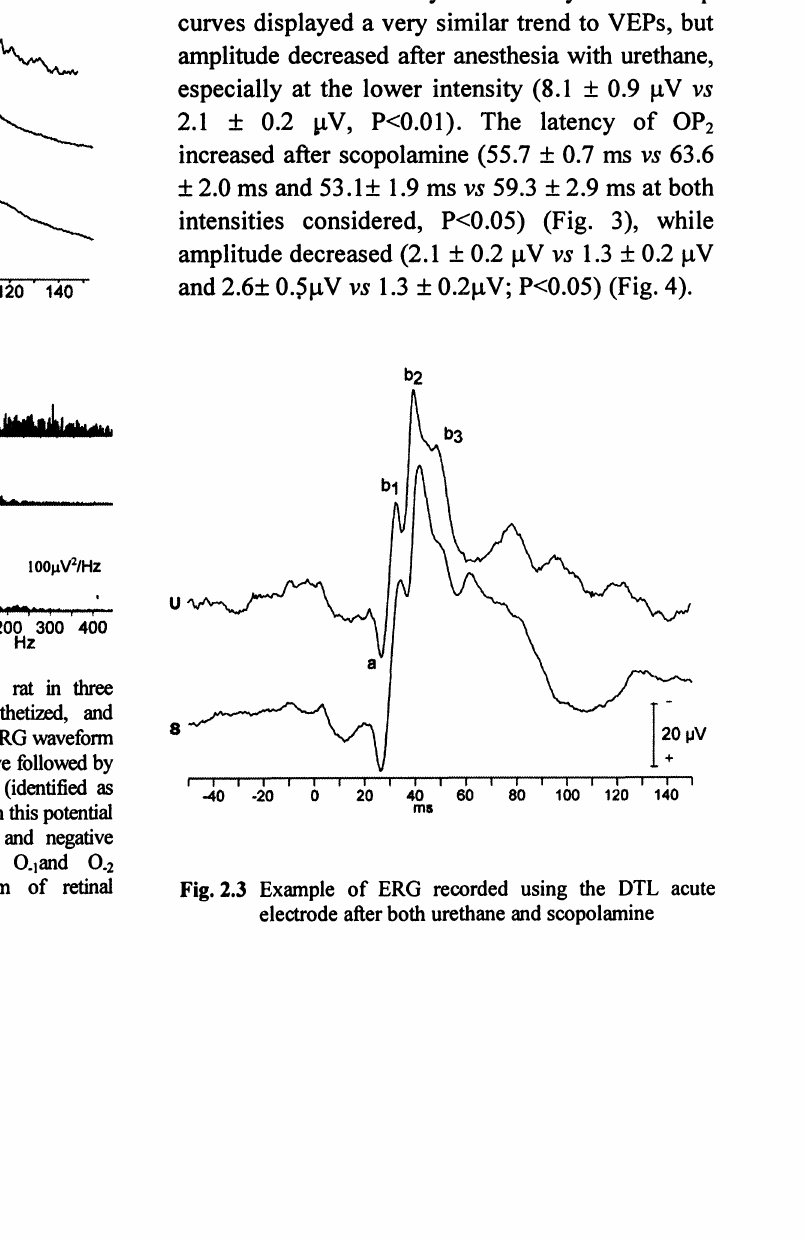
Fig. 2.2 A. Example of ERG recorded in rat in three different conditions: awake, anesthetized, and treated with scopolamine rat. The ERG waveform consists of an initial negative a- wave followed by the slow- high amplitude b-waves (identified as b 1, b2, and b3). B. Superimposed on this potential there is a train of high positive and negative frequencies (O1, 02, 03. and O.land 0.2 respectively). C. Power spectann of retinal oscillatory potentials shown in B.